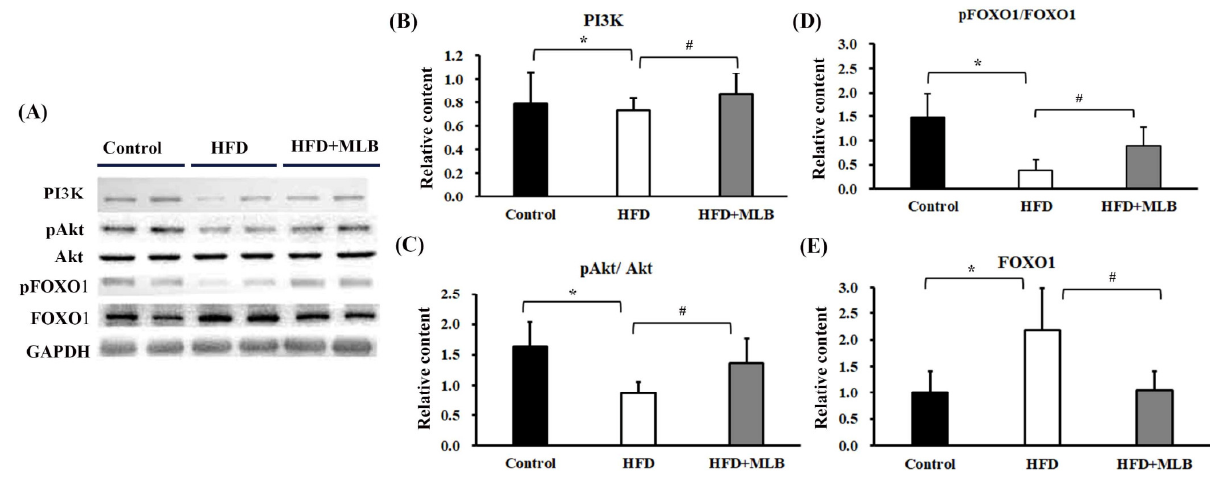
Figure 6. MLB supplementation attenuated HFD-induced muscle atrophy through the upregulation of PI3K/Akt/FOXO1 signaling. Proteins were isolated from skeletal muscles and subjected to a Western blot with antibodies against PI3K, pAkt, Akt, pFOXO1, FOXO1, and GAPDH. Two representative samples from each group are presented ( A ), and the quantitative data are depicted ( B – E ). Values are expressed as the mean ± SD. * p < 0.05 vs. control group. # p < 0.05 vs. HFD group. n = 8.